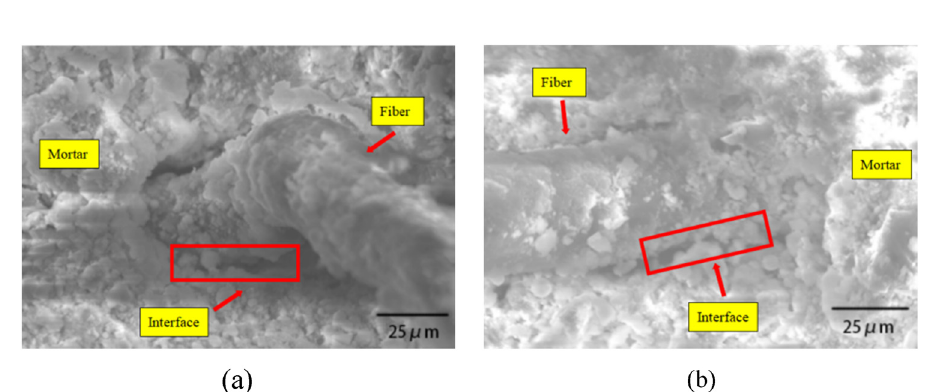
Figure 13: The SEM images of PVA fi ber after sulfate attack for 7 days. ( a ) Untreated and ( b )